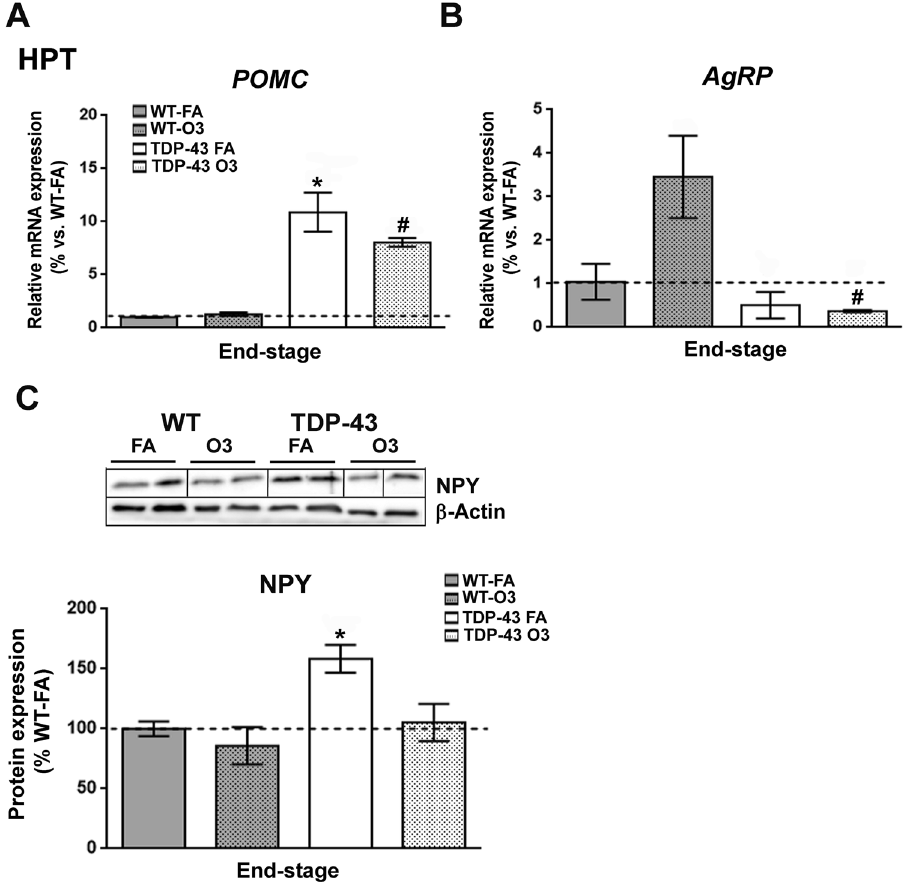
Figure 1. Alterations in anorexigenic and orexigenic neuropeptides in the hypothalamus of TDP-43 A315T mice in response to O 3 . ( A ) mRNA expression of POMC and ( B ) AgRP neuropeptides was assessed by RT-qPCR in the hypothalamus of TDP-43 A315T mice exposed to FA (n = 3 mice) or O 3 (n = 4 mice) compared to WT controls exposed to FA (n = 5 mice) or O 3 (n = 5 mice), at the end-stage of disease. ( C ) Representative β-Actin-normalized immunoblot images and quantification of NPY protein in the hypothalamus of TDP-43 A315T mice compared to age-matched WT littermate controls. The white lines in the immunoblot images represent the lanes that were run on the same gel but were non-contiguous. Values are expressed as the mean ± SEM for the different groups. Comparison between groups was performed by two-way ANOVA followed by Dunnett’s post hoc test to compare all groups with WT-FA, while Tukey’s post hoc test was used for multiple comparisons between all groups, where * p < 0.05 vs. WT mice FA-exposed; # p < 0.05 vs. WT mice O 3 -exposed; ** p < 0.05 vs. TDP-43 A315T FA-exposed. In the immunoblot images, representative bands were run on the same gel but were non-continuous. Abbreviations: WT, Wild-type mice; TDP-43,TDP-43 A315T mice; FA , filtered air; O 3 , ozone; HPT ,